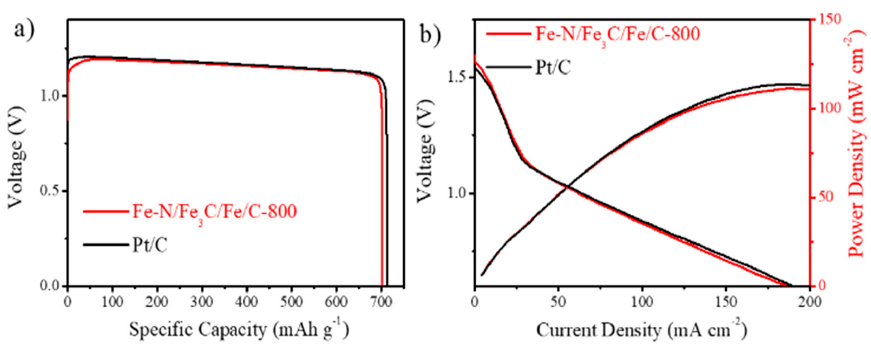
Figure 7. Zinc-air batteries performance. ( a ) Specific capacity under constant discharge current density (20 mA cm − 2 ) using the Fe-N/Fe 3 C/Fe/C-800 and Pt/C-based air cathodes. ( b ) Voltage-current curves and power density of two-electrode zinc-air batteries of the Fe-N/Fe 3 C/Fe/C-800 and Pt/C-based air cathodes in 6 M KOH.